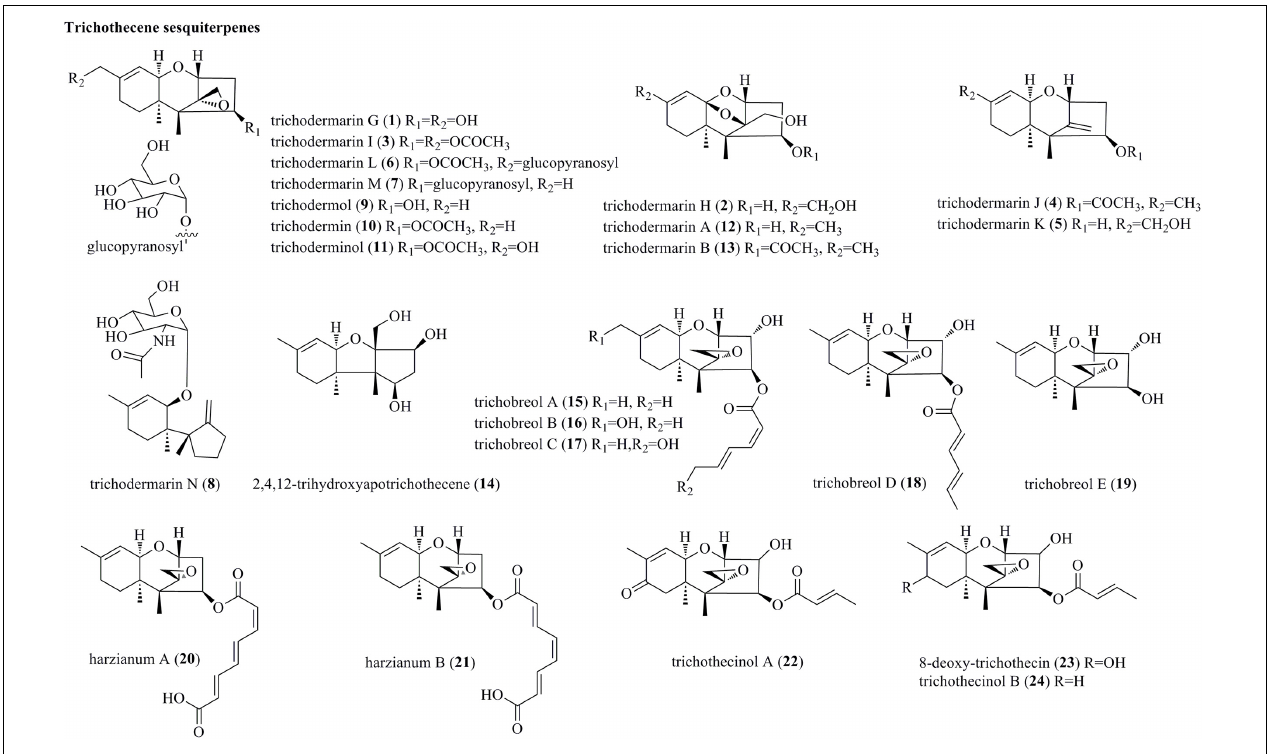
FIGURE 1 | Trichothecene sesquiterpenes produced by Trichoderma species ( 1–24